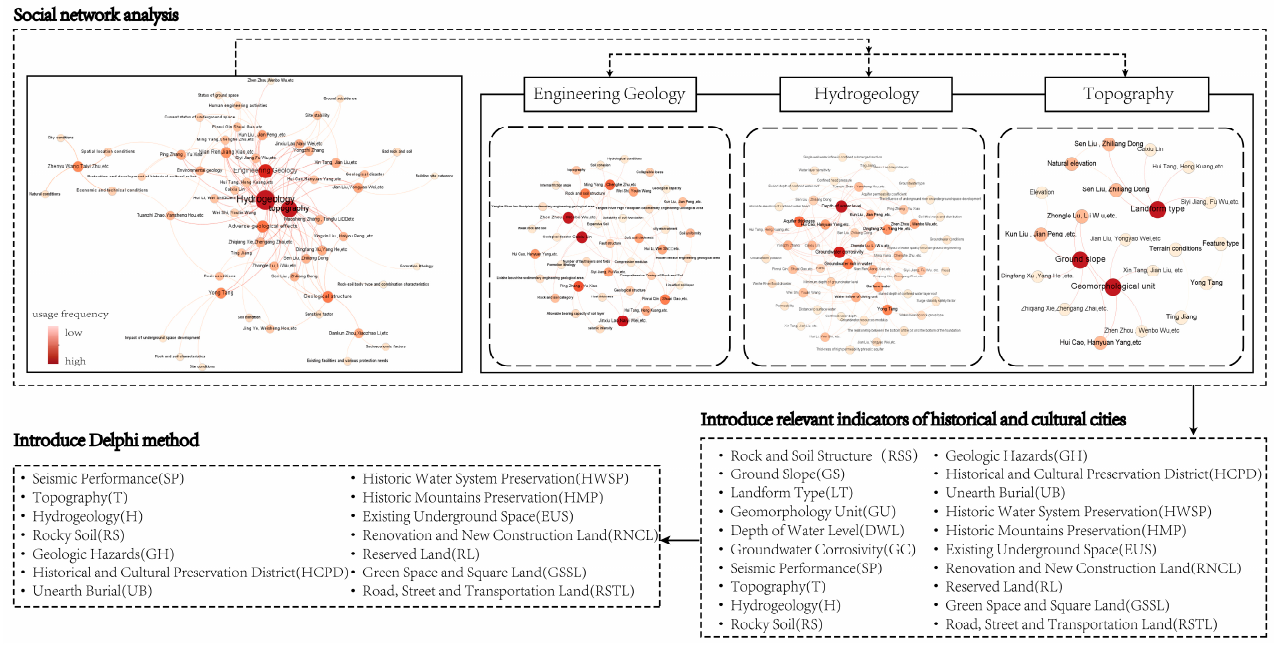
Figure 4. Construction process of qualitative index system.